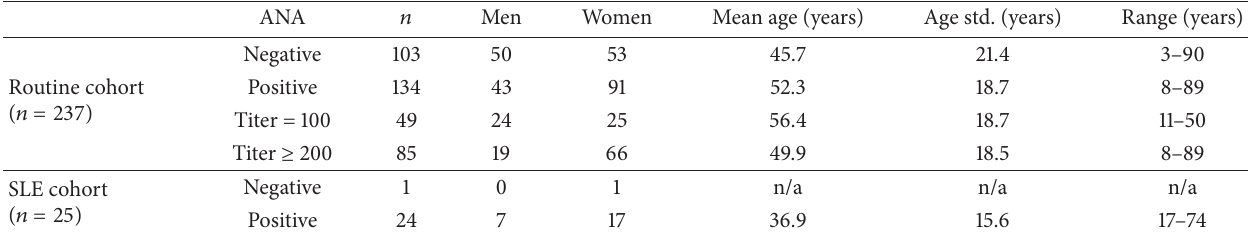
Table 1: Characteristics of patients from the routine and SLE